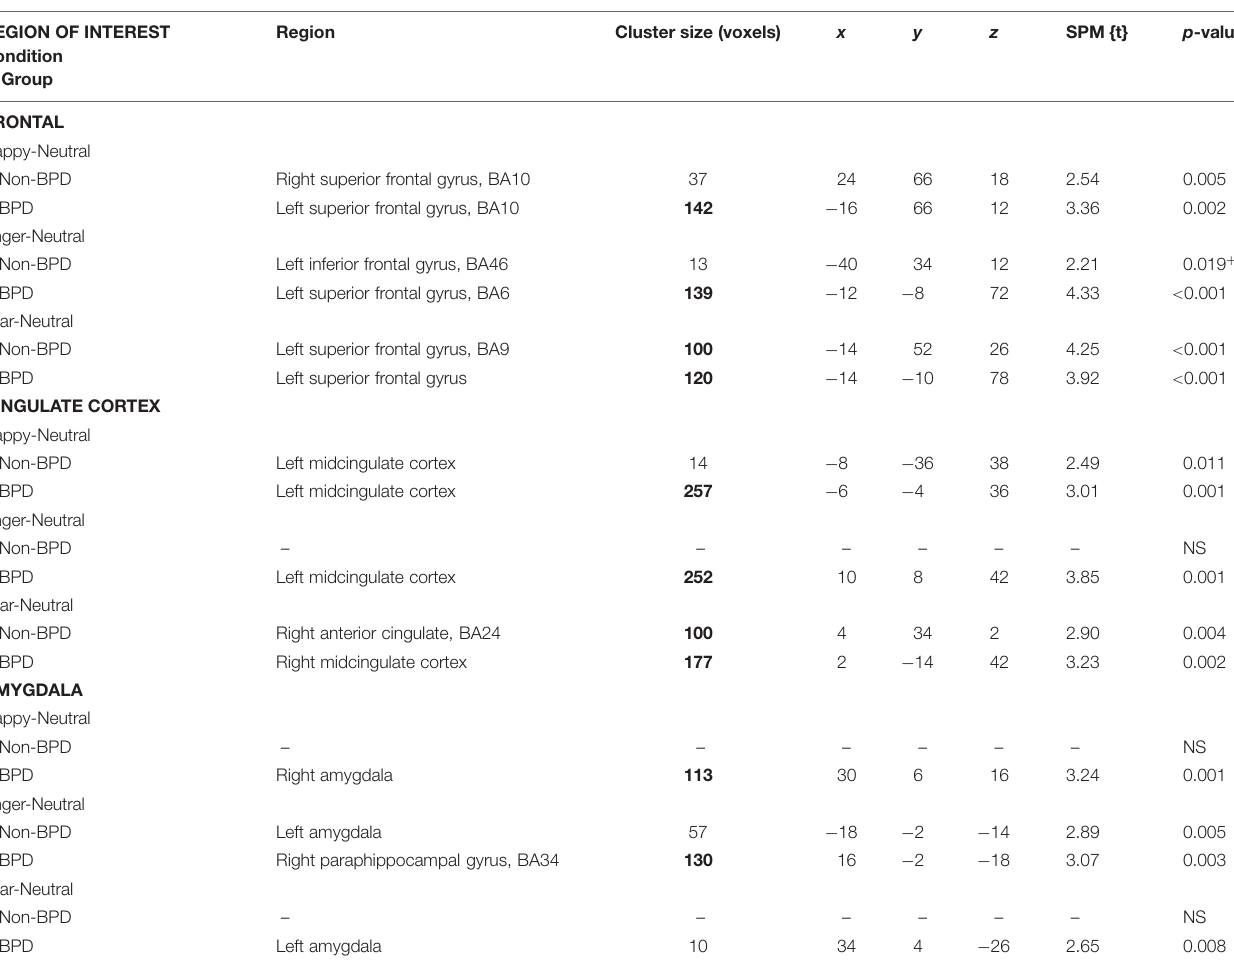
TABLE 1 | Masked affect fMRI results: single group